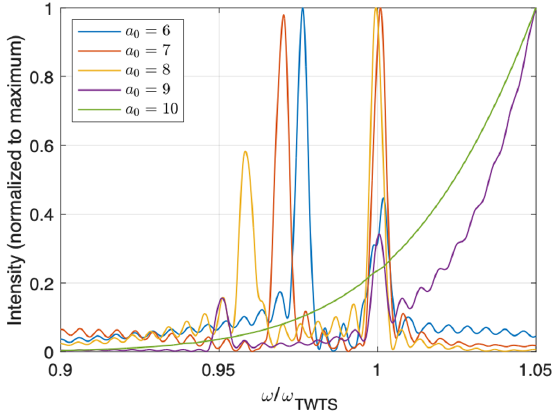
FIG. 5. Noise analysis for the simulations presented in Fig. 2(b). The field strength of the radiation reaction pulse is varied here to see the changes in noise for x-ray spectrum from the radiaiton reaction process. For a 0 ¼ 10 the TWTS signals are dominated by the noise. To increase the TWTS signals, either a stronger TWTS laser pulse or a longer TWTS interaction length is